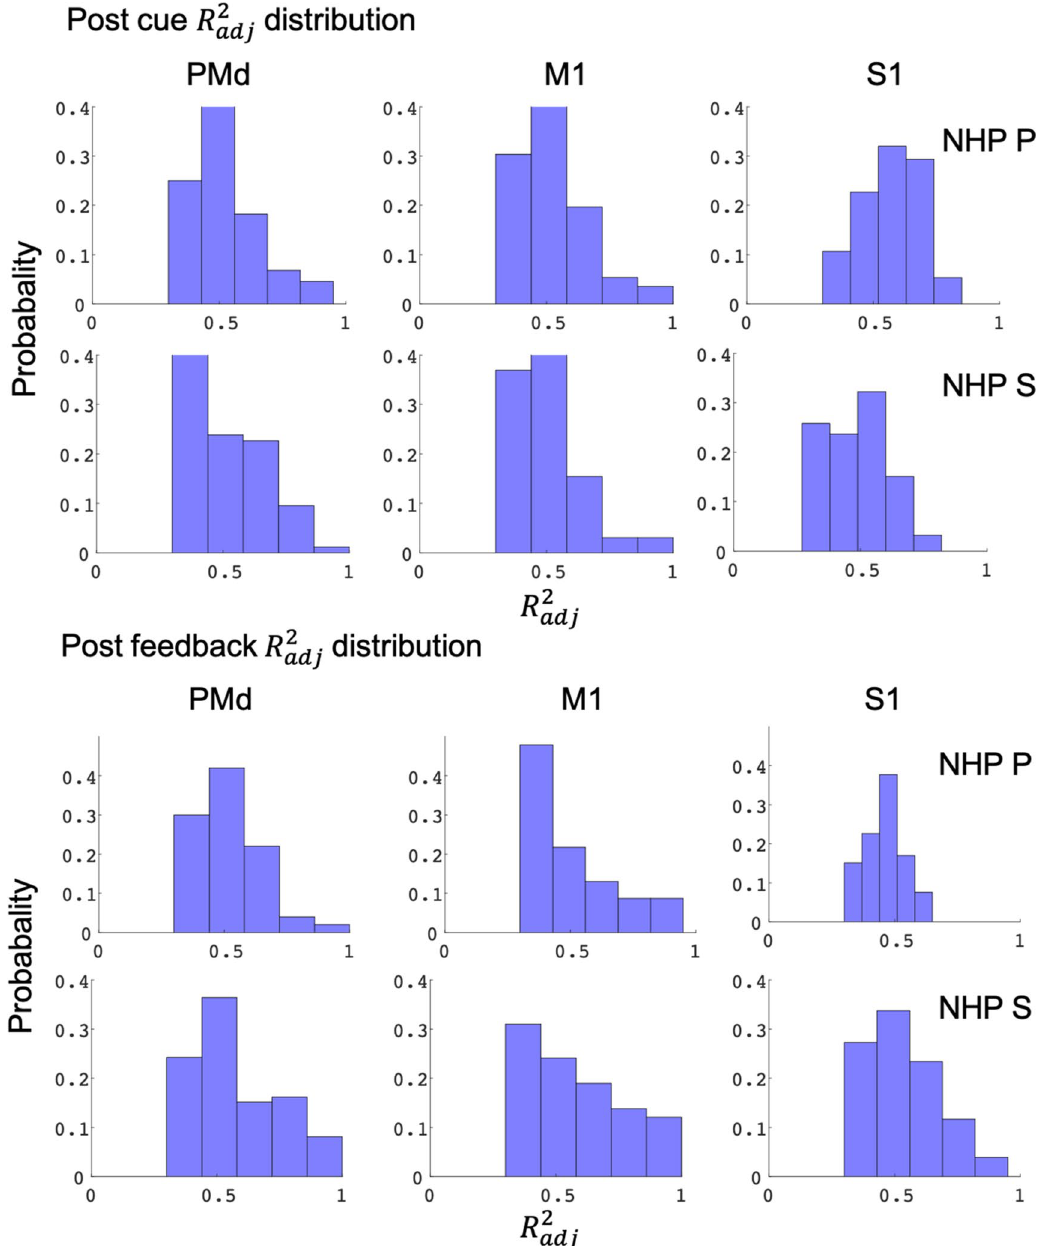
Figure 9. Distribution of the adjusted R squared values for the best significant model (model 2 and 3) fit for a given unit during the post-cue, top two rows, and the post-feedback, bottom two rows, for the two NHPs labeled on the right-hand side of the figure. Here we have fit the models to the mean firing rates for all 16 (R, P) levels; see supplementary figure S.Fig. 4 for the fit distributions utilizing every trial rather than the 16 (R, P) categorical